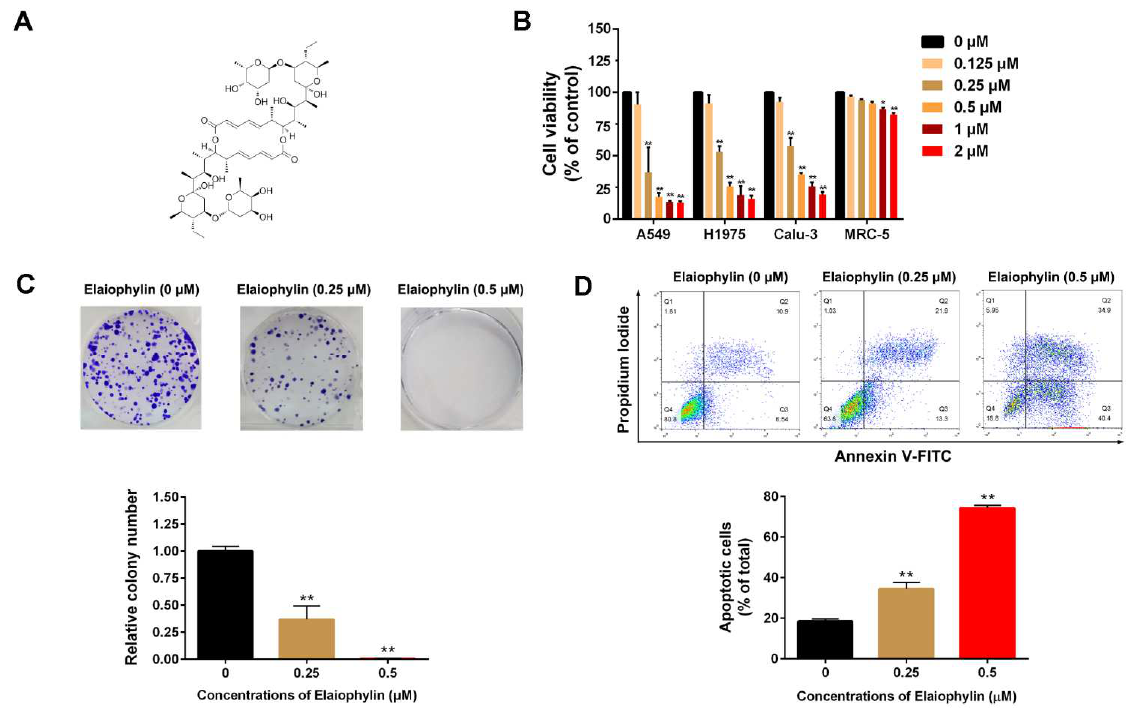
Figure 1. Elaiophylin inhibits cell viability and induces cell apoptosis in A549 cells. ( A ) The chemical structure of elaiophylin. ( B ) A549, H1975, and Calu-3 cells were treated with elaiophylin (ranging from 0 to 2 µM) for 24 h, and cell viability was determined by MTT assay. ( C ) A549 and MRC-5 cells were treated with elaiophylin (ranging from 0 to 2 µM) for 24 h, and cell viability was determined by MTT assay. ( D ) A549 monoclonal cells were treated with elaiophylin for 24 h and then continu- ously cultured for 14 days. The formation of colonies was determined by crystal violet staining. ( E ) A549 cells were treated with elaiophylin (0, 0.25, and 0.5 µM) for 24 h, and cell apoptosis was deter- mined by Annexin V/PI staining using flow cytometry. Apoptotic cell proportions were shown in bars. Data were expressed as means ± SD of three independent experiments and each experiment included triplicated repeats. * p < 0.05, ** p < 0.01 vs. control.